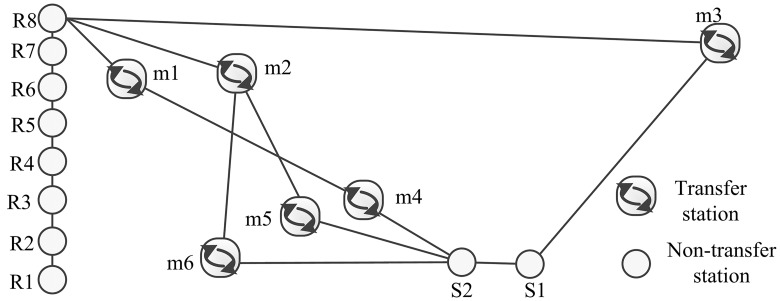
A diagram of deleted OD pairs and routes.The origin stations are denoted as R; the destination stations are denoted as S; the transfer stations are denoted as m. Other stations are omitted in the figure. It means transferring if the route passes by a transfer station.